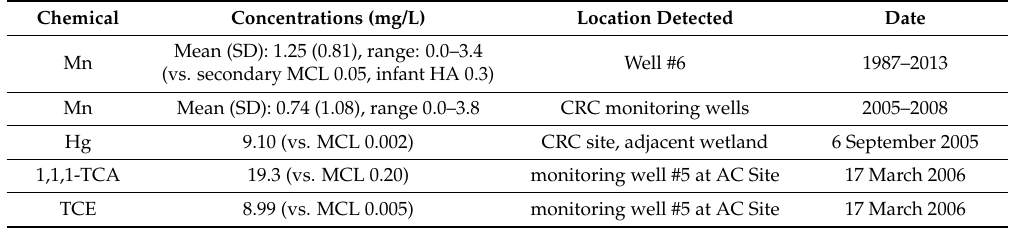
Table 3. Levels of Mn, Hg, trichloroethane (TCA), and trichloroethylene (TCE) from secondary data.